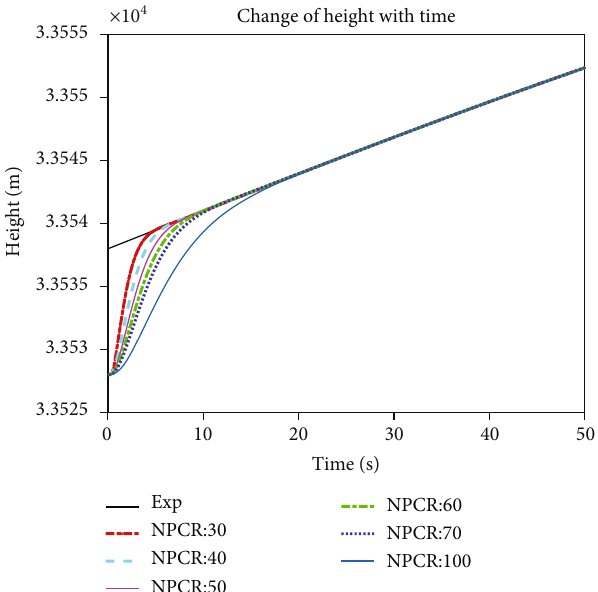
Figure 8: Height changes with time under di ff erent prediction steps.